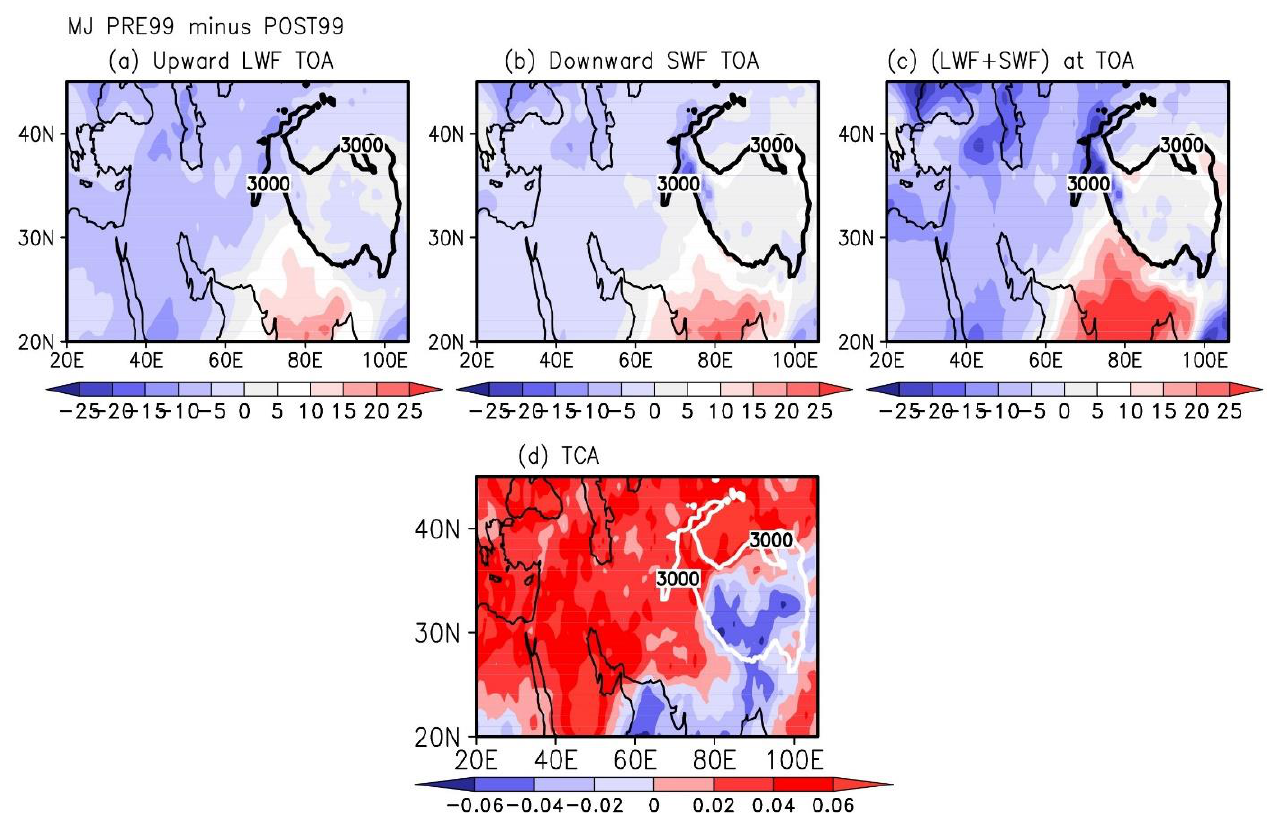
Figure 6. ( a ) The top of atmosphere MJ mean upward LWF (Wm − 2 ) during PRE99 − POST99, ( b ) as in ( a ), but for downward SWF; and ( c ) is the same as ( a ), but for LWF + SWF. ( d ) TCA fraction during PRE99 − POST99.